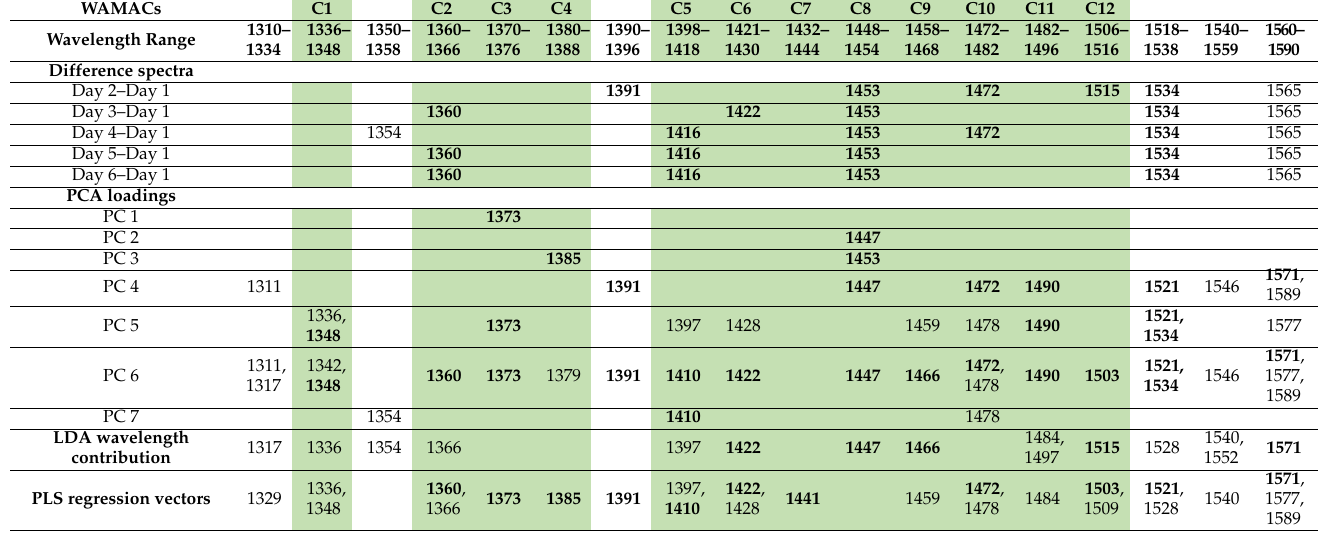
Table 3. Prominent wavelengths for statistical modeling on the data of inner leaves.